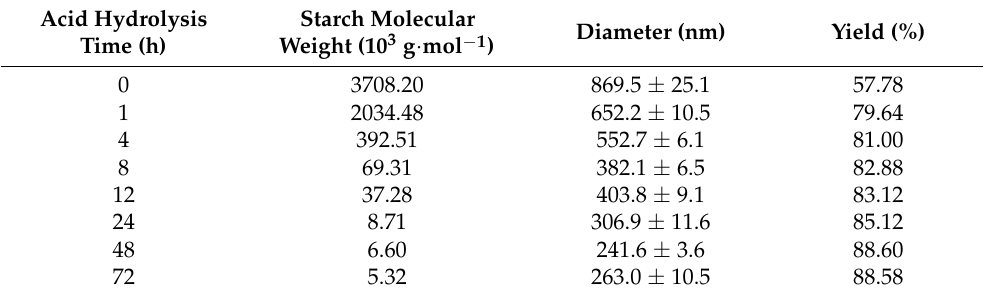
Table 1. Effects of acid hydrolysis time on the molecular weight of acid-treated starch and the size and yield of